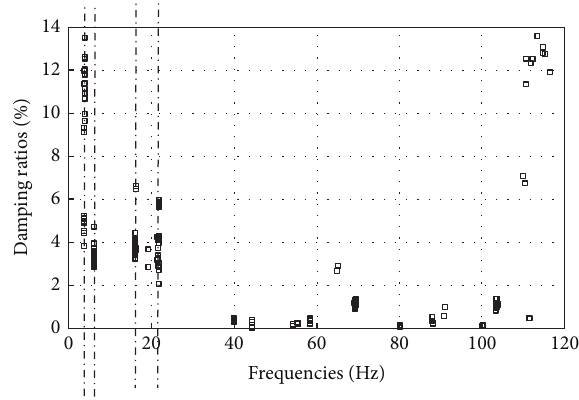
Figure 7: Repartition of damping